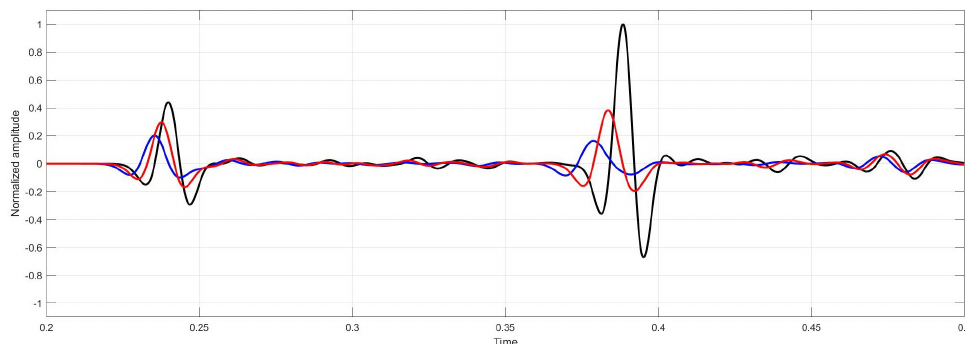
Figure 5. Comparison of three seismic traces on the z = 0 line. Black corresponds to a perfectly elastic medium, red corresponds to a target layer with a Q factor of 20, and blue corresponds to a target layer with a Q factor of